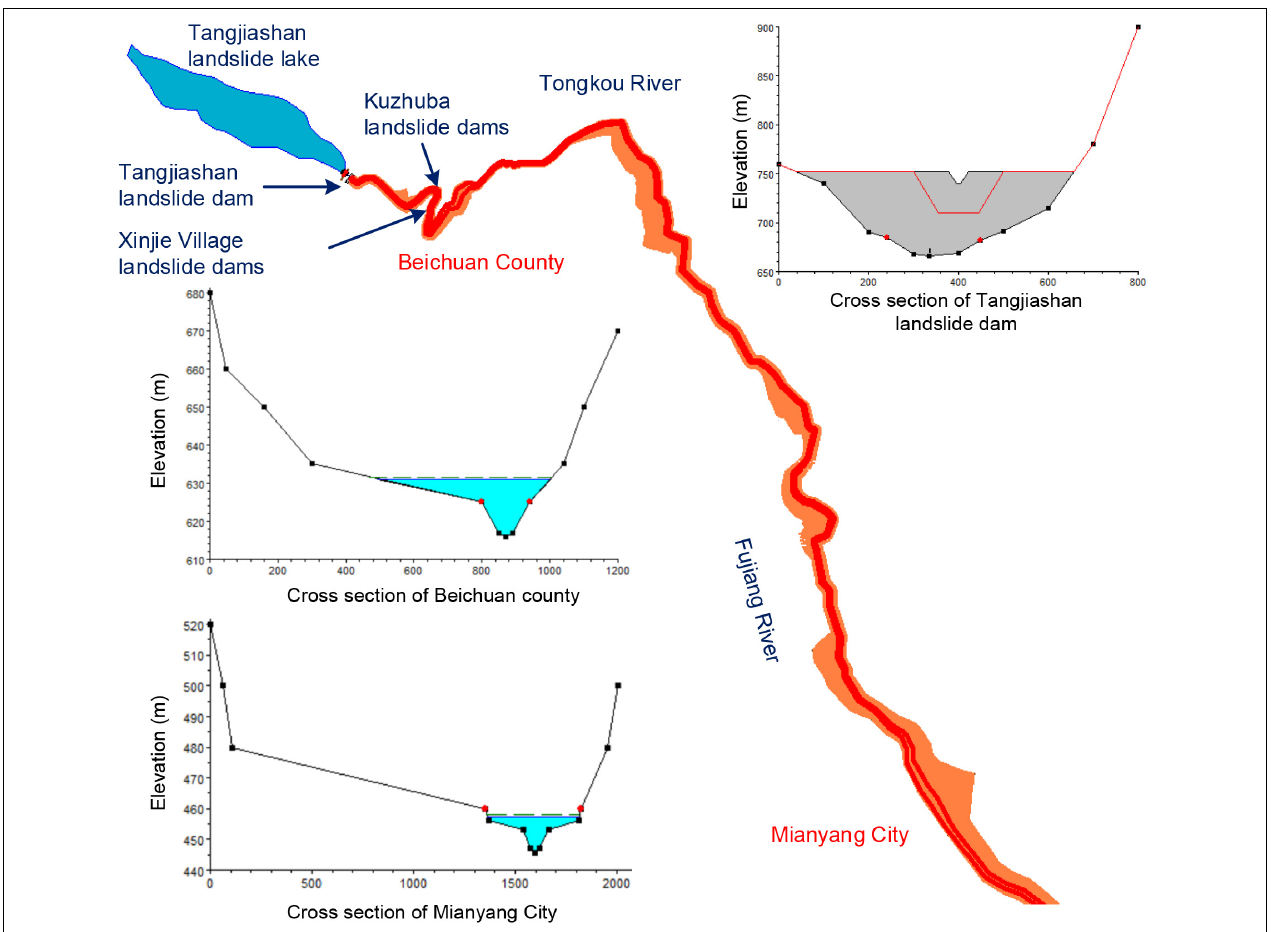
FIGURE 6 | The geometry model of the Tangjiashan landslide dam and the river downstream based on HEC-RAS (Hydraulic Engineering Center,